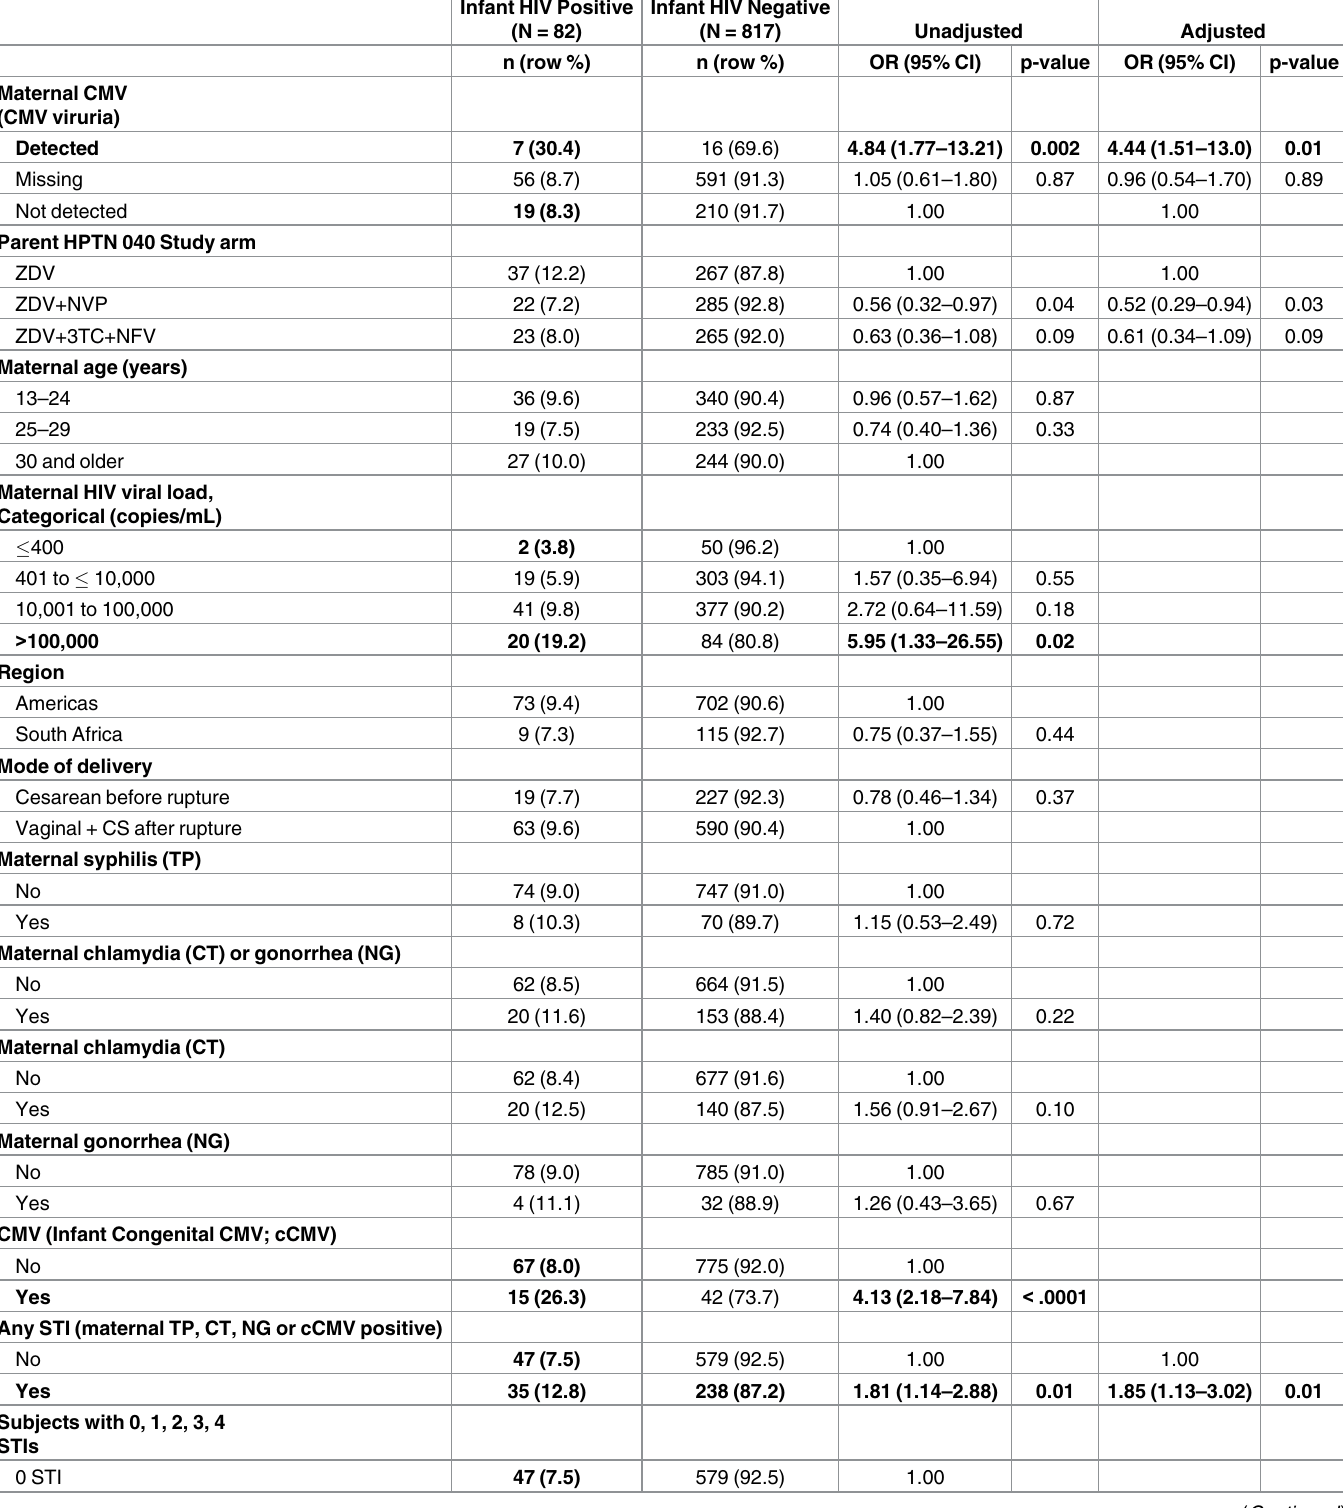
Table 3. Relationship of Infant HIV transmission with risk